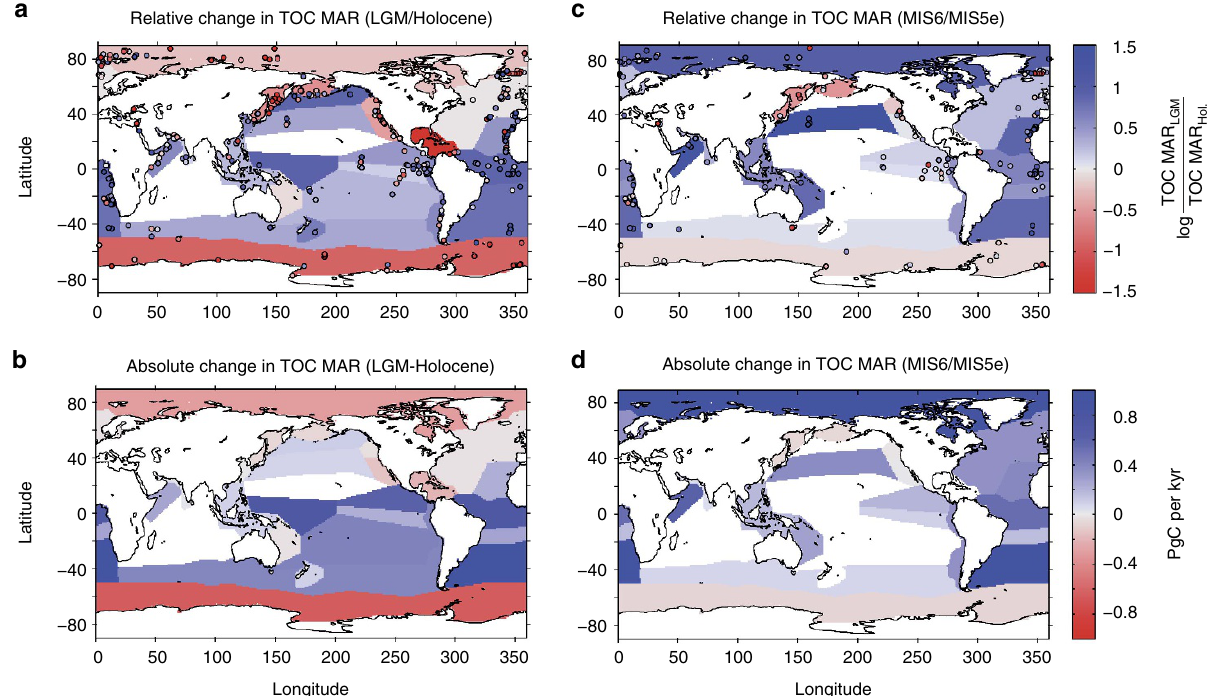
Figure 1 | Relative and absolute changes in deep-sea burial of organic carbon for the two last deglacial transition. Relative ( a , c ) and absolute ( b , d ; PgC per kyr) changes in deep-sea burial of organic carbon from MIS2 to Holocene transition ( a , b ) and MIS6 to MIS5e transition ( c , d ). Individual sedimentary ratios are shown as coloured circles in a , c . Shadings correspond to the mean ratio in each province ( a , c ) and to the absolute changes in b , d . Note that ( b , d ) show total burial changes in each province, and the absolute changes are not area-normalized. NATURE COMMUNICATIONS|7:10796|DOI: